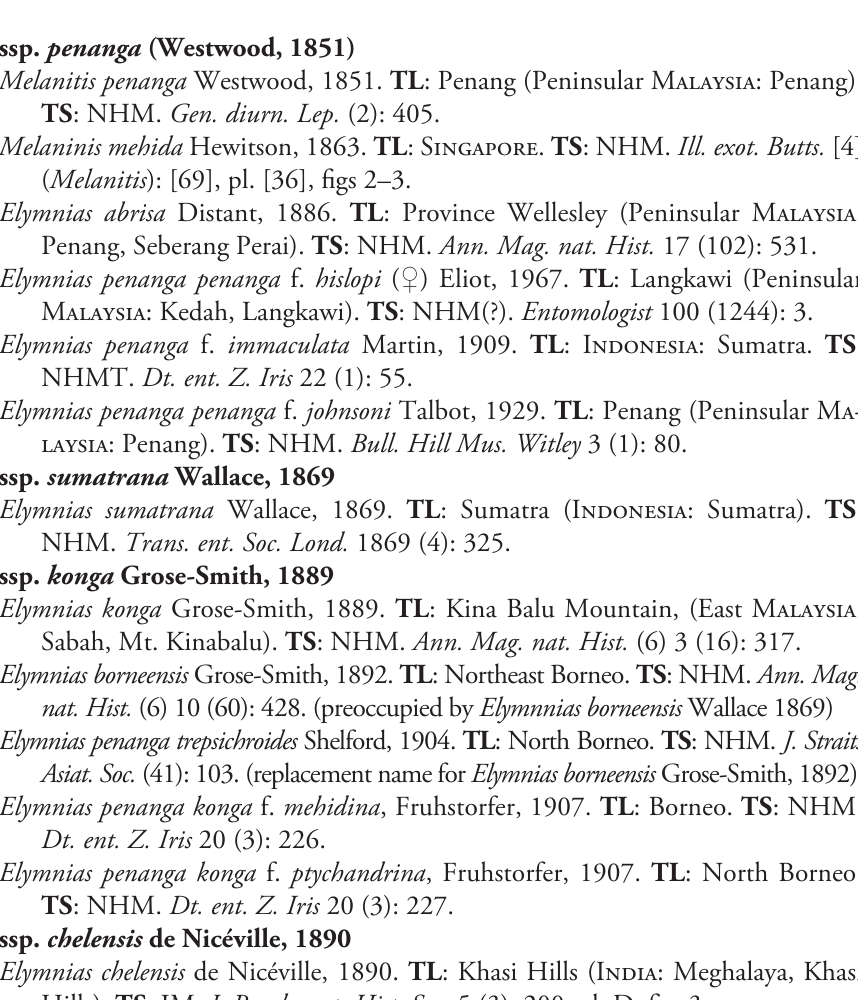
Specimens: Figs 5A–N, 6A–P, 7A–O, 8A–H; Male Genitalia: Fig. 23A–K; Distri- bution: Fig.